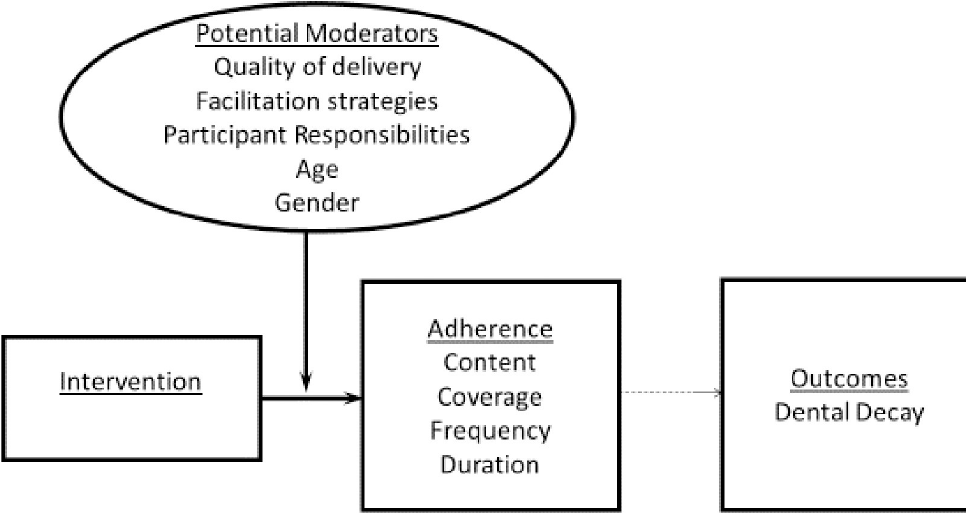
Fig 1. Modified framework adapted from Carrol et al,